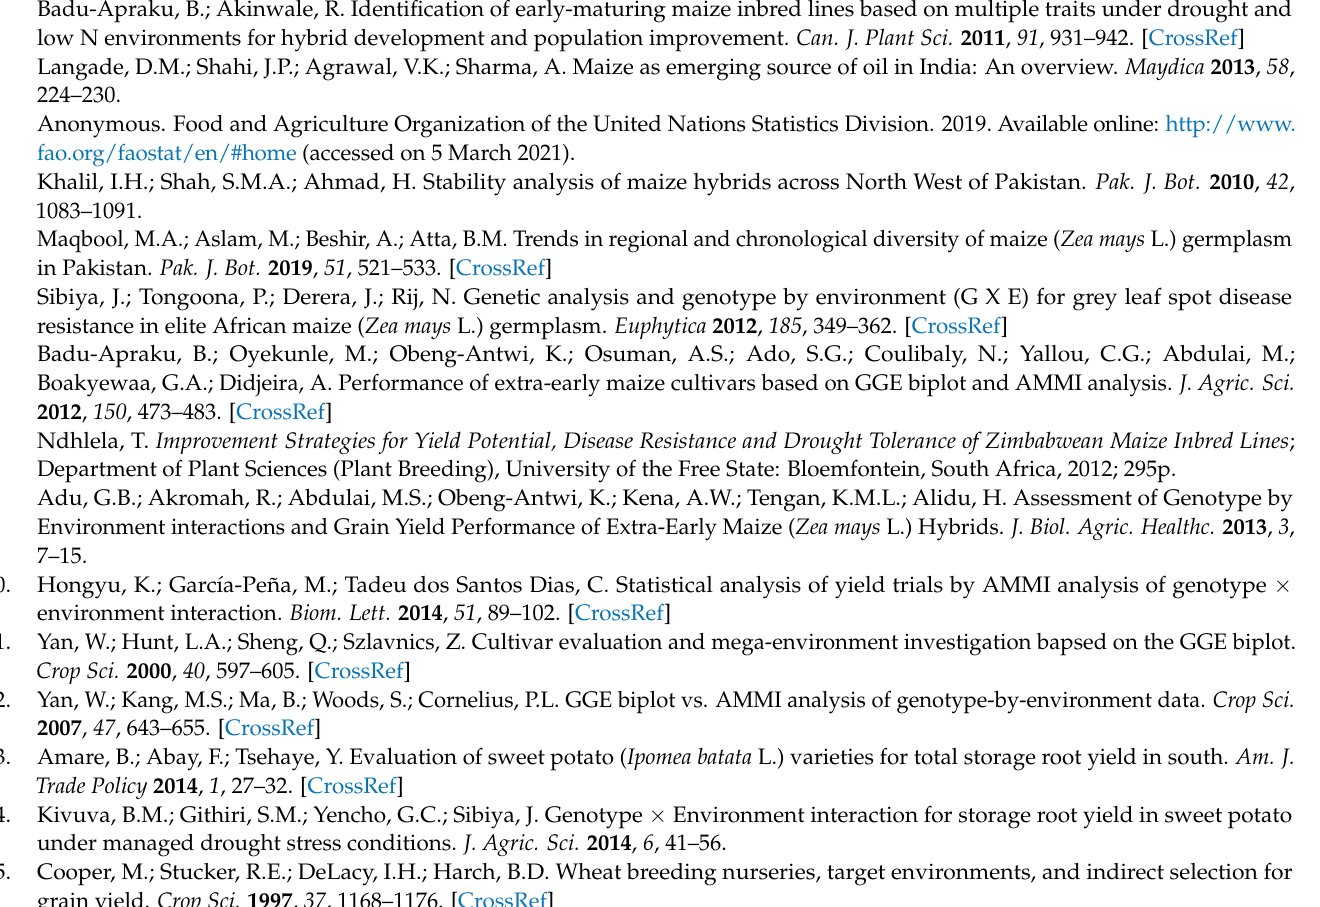
Table S2: Multiple comparison results by the LSD method over two